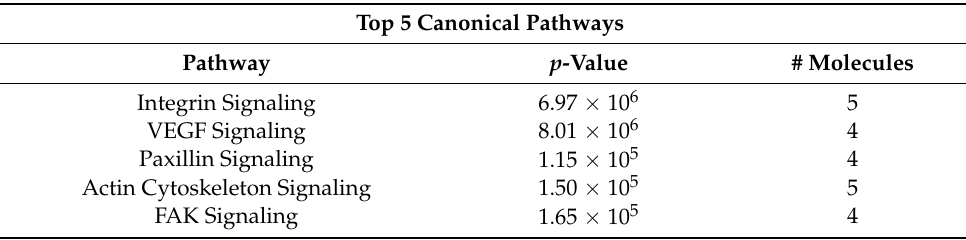
Table A4. IPA analyses on the 28 proteins that were elevated (AUC ≥ 0.60) in case plasmas collected at the time of diagnosis of SCLC and that were quantified in conditioned medium of SCLC cell